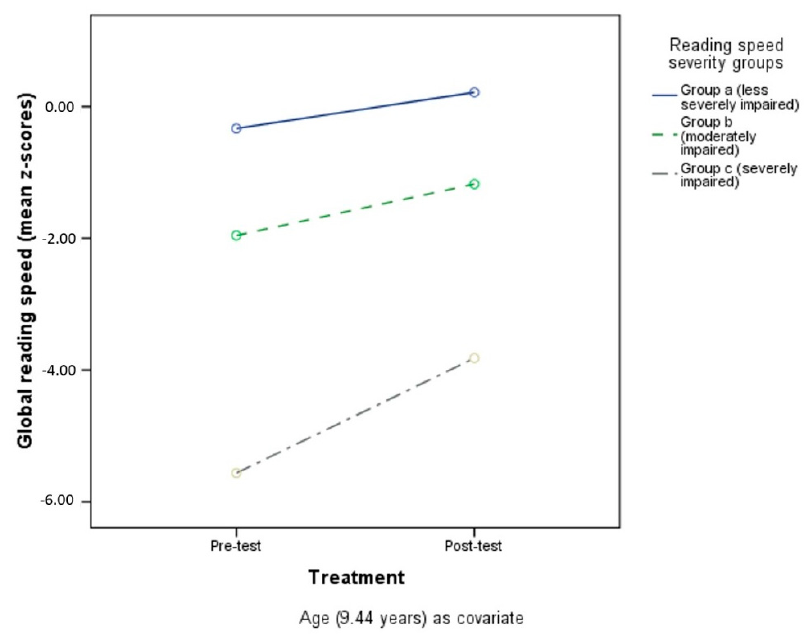
Figure 1. Pre- and post-test reading speed in the three different impairment severity groups. For global reading accuracy, a difference was found between Group a (less severely impaired) and Group b (moderately impaired) ( p < 0.001), Group a (less severely impaired) and Group c (severely impaired) ( p < 0.001), and Group b (moderately impaired) and Group c (severely impaired) ( p < 0.001). See Figure 2 for performances of reading accuracy impairment severity groups (with age as a